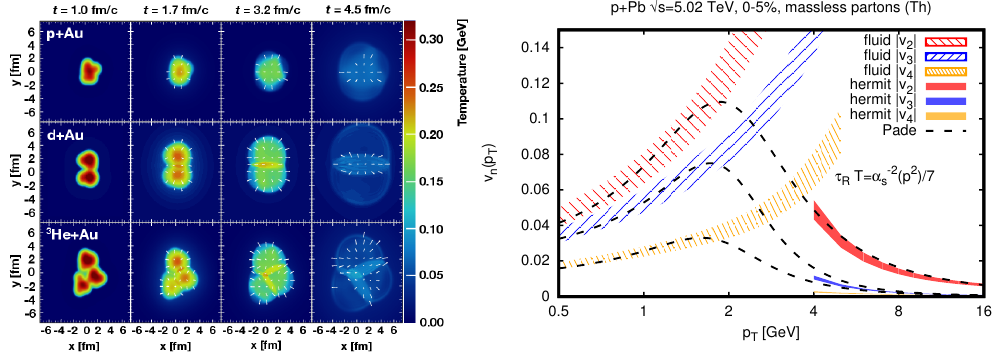
Figure 1. Left: Demonstration of hydrodynamic expansion of QGP medium in small collision systems, as part of the RHIC “projectile scan,” from Ref. [4]. Right: Calculated v 2 , 3 , 4 values in central p + Pb collisions at low and high p T , from Ref.